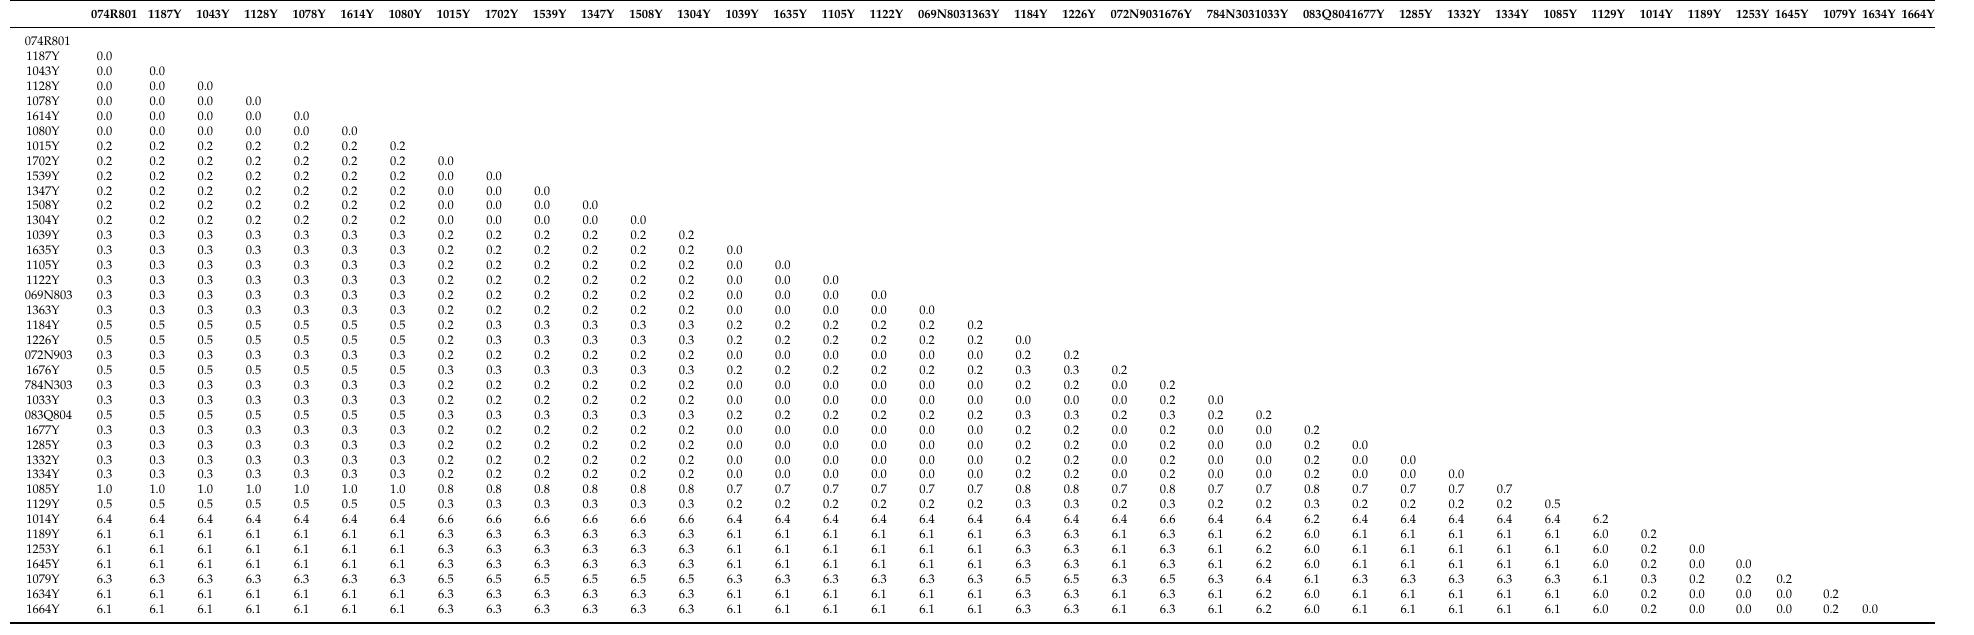
Table 2. Percentage of pairwise distances obtained for the sequences of COI genes